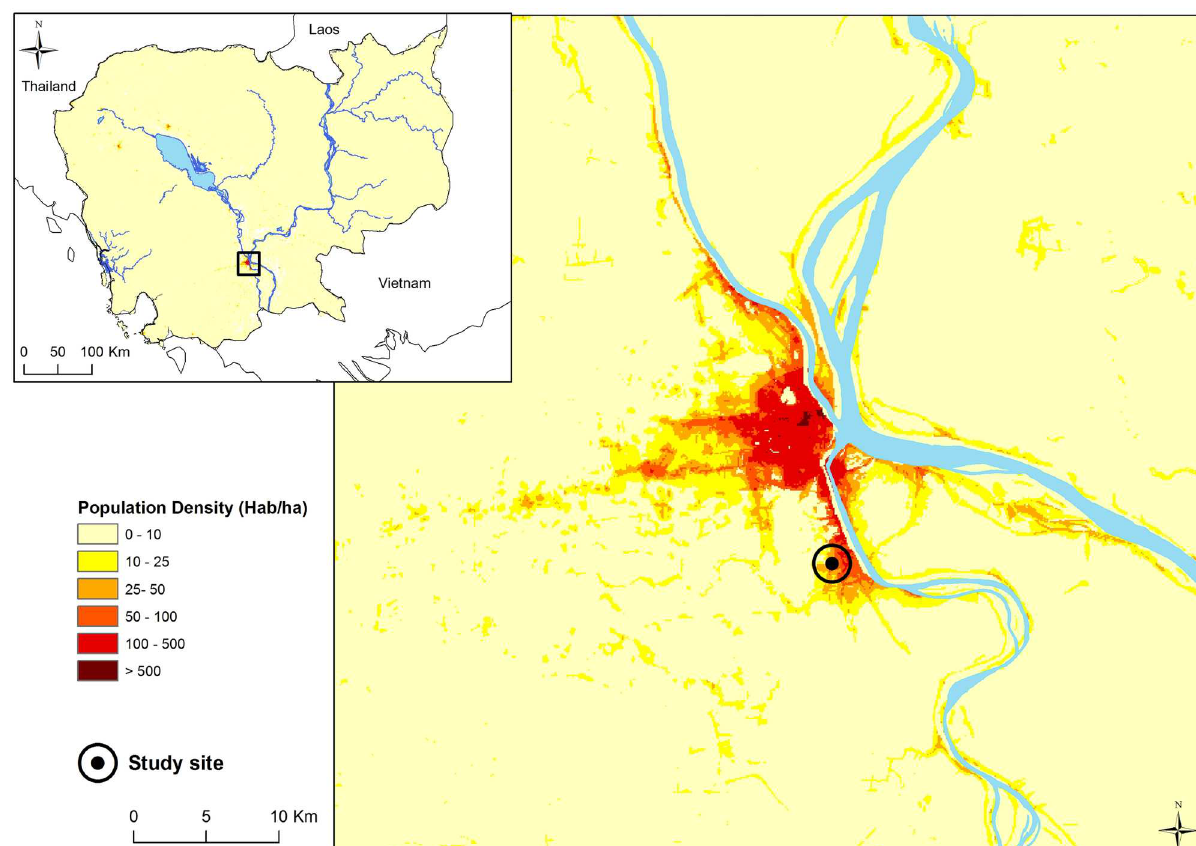
Fig 5. Location of the study site in a periurban area of Phnom Penh, Cambodia. Populationdensity data are extracted from the WorldPopproject